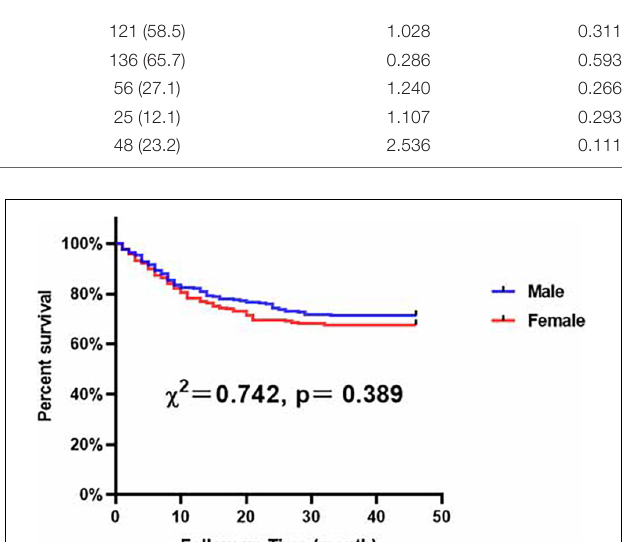
FIGURE 5 | Major adverse cardiovascular and cerebrovascular events-free survival rates for male and female patients with LEASO during the follow-up period.